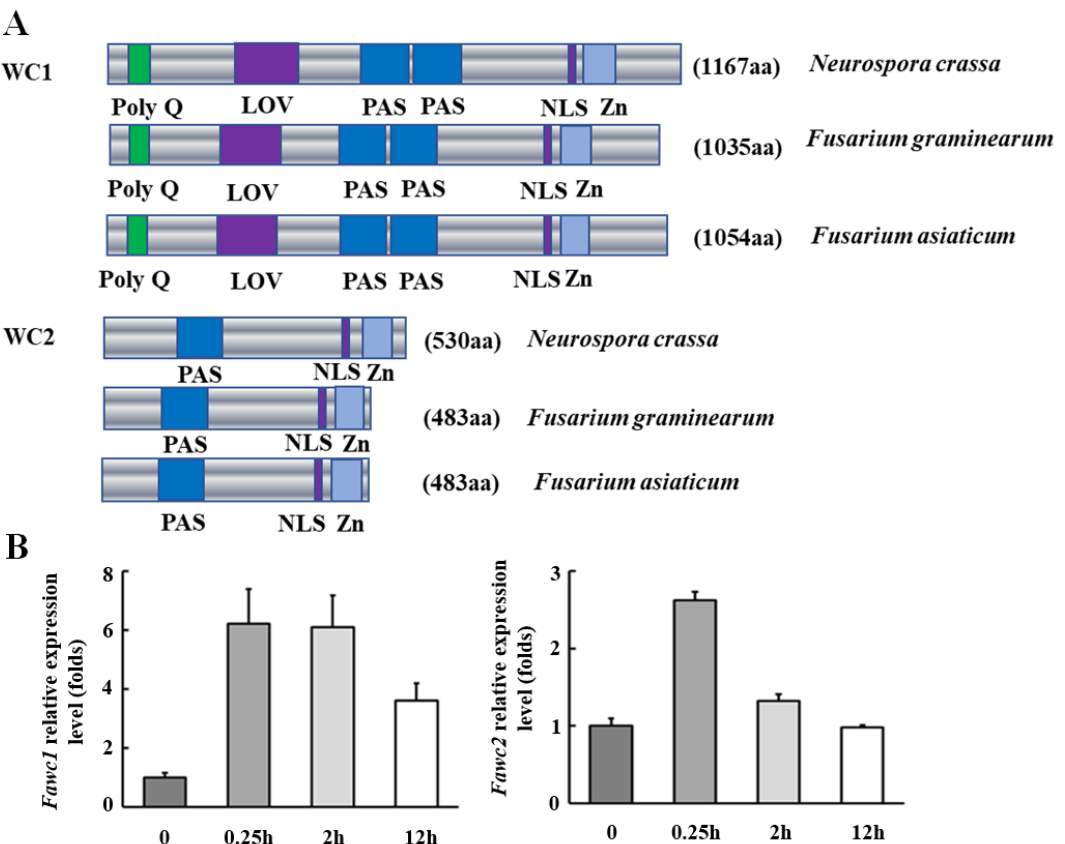
Figure 1. Identification of two photoreceptor genes, Fawc1 and Fawc2 , in F. asiaticum . ( A ). Schematic demonstration of the domains of WC1 and WC2 orthologs from N. crassa , F. graminearum , and F. asiaticum . Accessions of the amino acid sequences are as follows: WC1 (NCU02356); WC2 (NCU00902); FgWC1 (FGSG_07941); FgWC2 (FGSG_00710); FaWC1 (KX905081.1); FaWC2 (MT019868). Domains of these photoreceptor proteins were analyzed via the SMART online tool (http: // smart.embl-heidelberg.de / ). PAS: Per-period circadian protein; Arnt: Ah receptor nuclear translocator protein; Sim: Single-minded protein, NLS: Nuclear Location Singal, Zn: Zinc finger binding to DNA consensus sequence. ( B ). Transcript levels of Fawc1 and Fawc2 are regulated by light. The horizontal axis indicates light treatment time. The bars present mean values ± SD of three replicate samples.